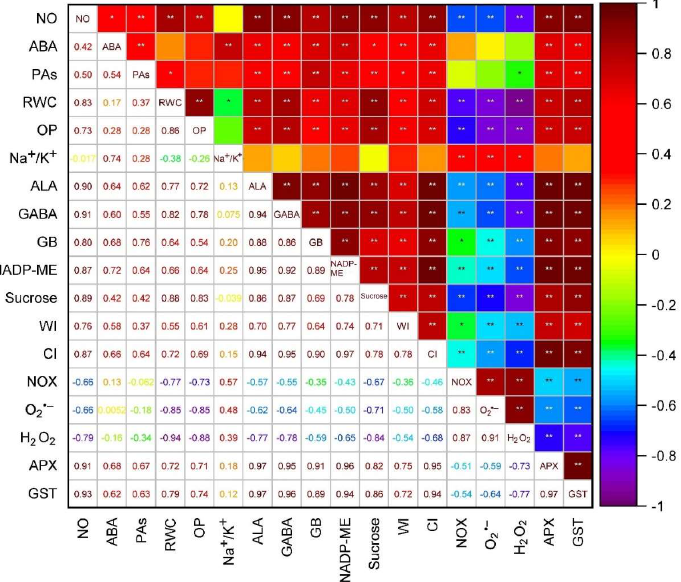
Figure 12. The Pearson’s correlation matrix among the parameters performed in the experiment. Loading plot: NO—nitric oxide content, ABA—abscisic acid content, PAs—total polyamines con- tent, RWC—relative water content, OP—osmotic potential, Na + /K + —ratio of Na + and K + , Alanine— alanine content, GABA—gamma aminobutyric acid content, GB—glycine betaine content, NADP- ME—NADP-malic enzyme activity, Sucrose—sucrose content, WI−wall-bound invertase activity, CI—cytosolic invertase activity, NOX—NADP(H) oxidase activity, O 2 • − —superoxide generation, H 2 O 2 —hydrogen peroxide accumulation, APX—ascorbate peroxidase activity, GST—glutathione S - transferase